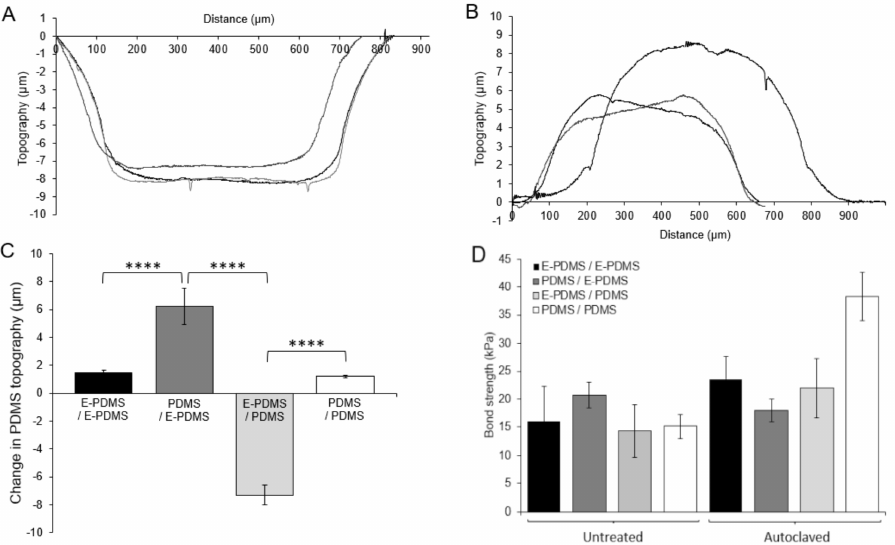
Figure 4. Measurement of deformation and removal forces for E-PDMS and PDMS in direct contact with each other. ( A , B ) Stylus profilometry data (Sloan Dektak3ST Profilometer) confirms the visual observations and profiles topological changes of E-PDMS and PDMS deformation when extracted and non-extracted PDMS samples are paired in direct contact and autoclaved. ( C ) Summary of topography changes of PDMS and E-PDMS material slabs from profilometry data of E-PDMS and PDMS plugs processed in pairwise combinations. The PDMS/E-PDMS combinations show much greater changes (3 repeats (n = 3 each), one-way ANOVA) than both E-PDMS/E-PDMS- and PDMS/PDMS-matched material types, which show no significant changes. ( D ) Adhesion testing measurements of untreated and autoclave-annealed E-PDMS and PDMS plugs on E-PDMS and PDMS elastomer slabs. Weak adhesion forces for PDMS on PDMS are higher than any E-PDMS interactions and are attributed to the remaining oligomers and metal catalysts left in the bulk polymer (no significance). p values for differences are indicated by asterisks, p ≤ 0.0001